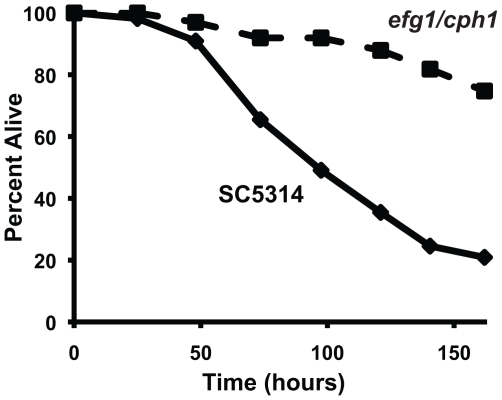
A C. albicans double mutant strain that is attenuated for pathogenicity in mammals is also unable to efficiently kill C. elegans.The C. albicans efg1Δ/efg1Δ cph1Δ/cph1Δ double mutant strain (efg1/cph1) exhibited a reduced ability to kill C. elegans compared to its isogenic wild-type parent strain SC5314 (P<0.001). The graph presents the average of three plates per strain, each with 30 to 40 animals per plate. Data are representative of two biological replicates.